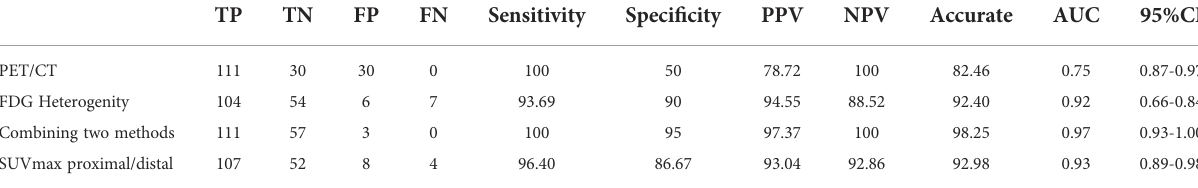
TABLE 3 Diagnostic ef fi ciency of different methods.